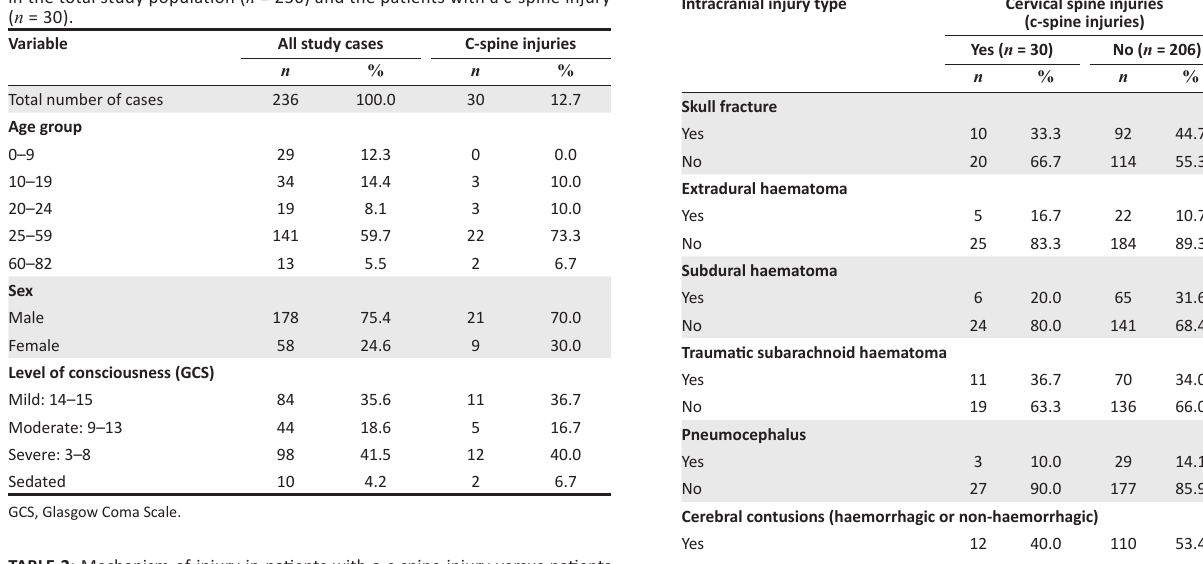
TABLE 2: Mechanism of injury in patients with a c-spine injury versus patients with no c-spine